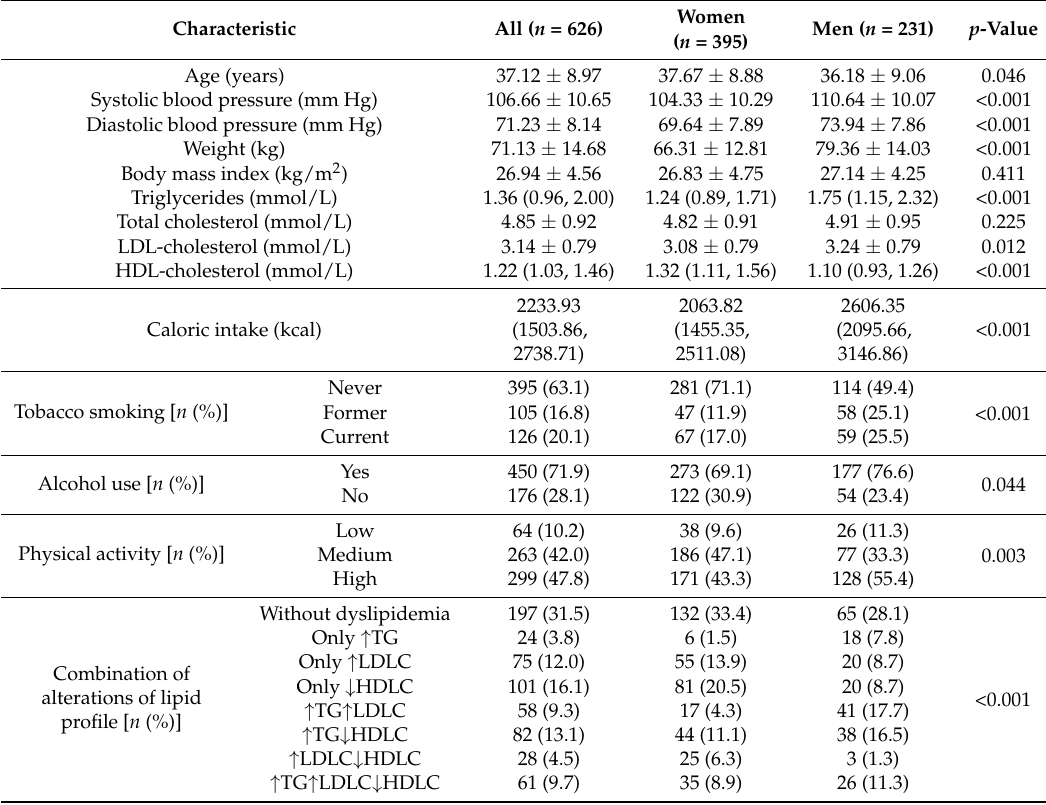
Table 1. General characteristics of